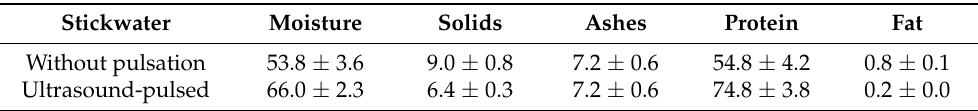
Table 1. Proximal chemical composition of Stickwater. Stickwater Moisture Solids Ashes Protein Fat Without pulsation 53.8 ± 3.6 9.0 ± 0.8 7.2 ± 0.6 54.8 ± 4.2 0.8 ± 0.1 Ultrasound-pulsed 66.0 ± 2.3 6.4 ± 0.3 7.2 ± 0.6 74.8 ± 3.8 0.2 ± 0.0 Results are expressed as the average of five